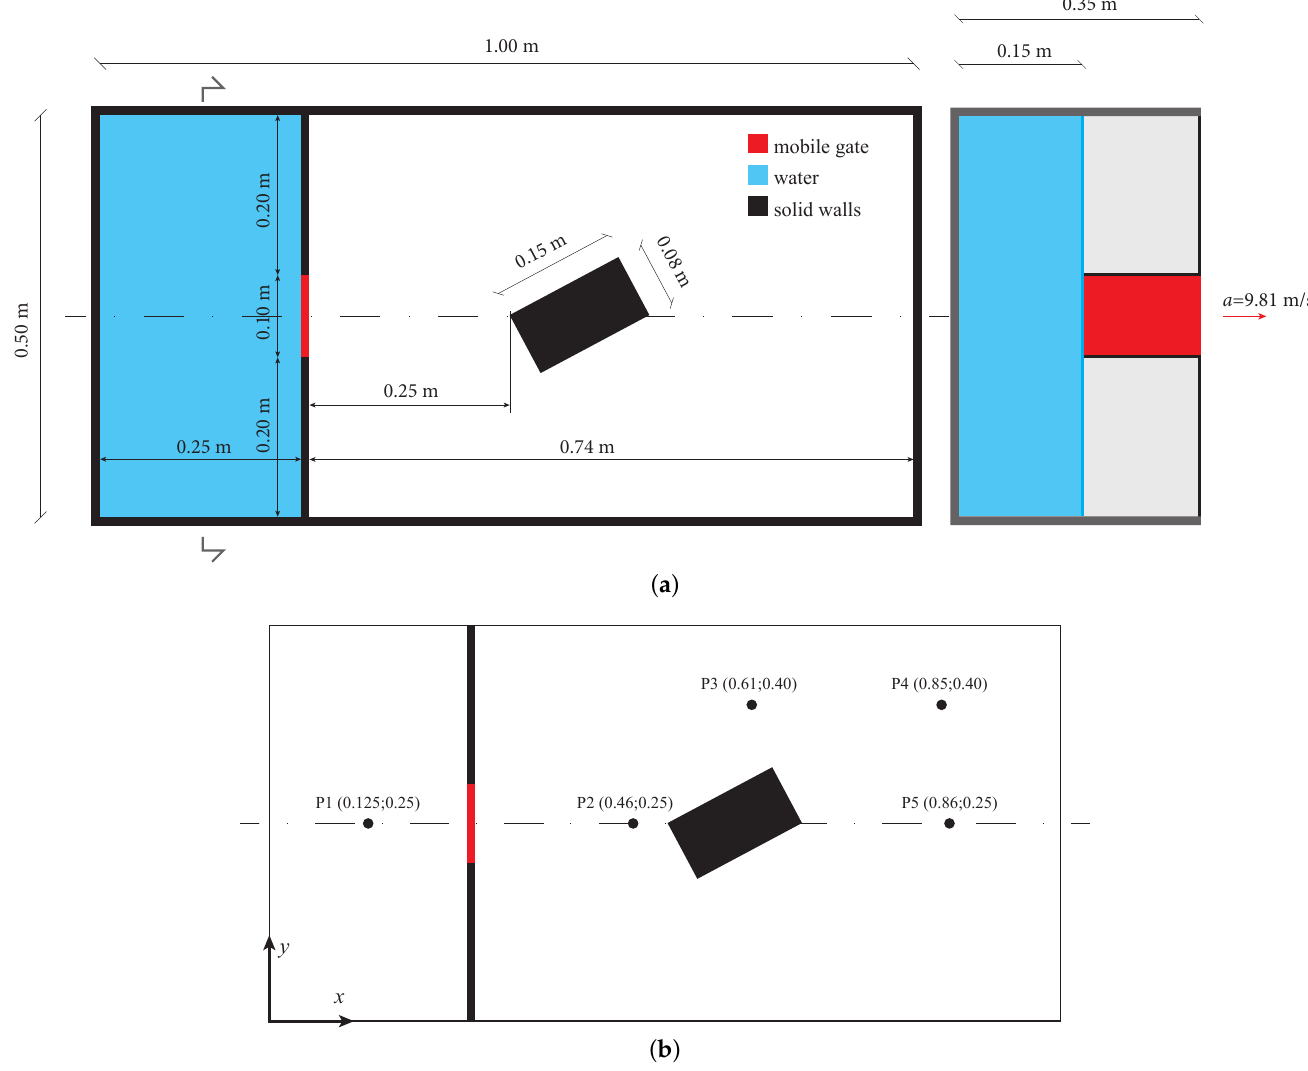
Figure 1. Planar and section scheme of the simulation domain ( a ) and measurement points positions ( b